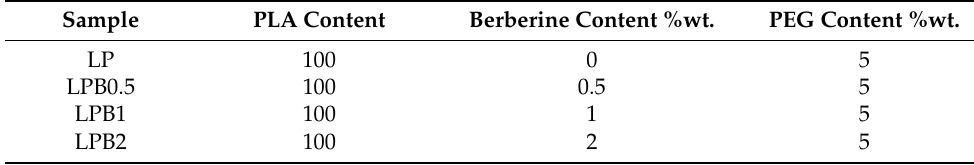
Table 1. Make-up of investigated materials (L—polylactide; P—PEG, B—berberine). Sample PLA